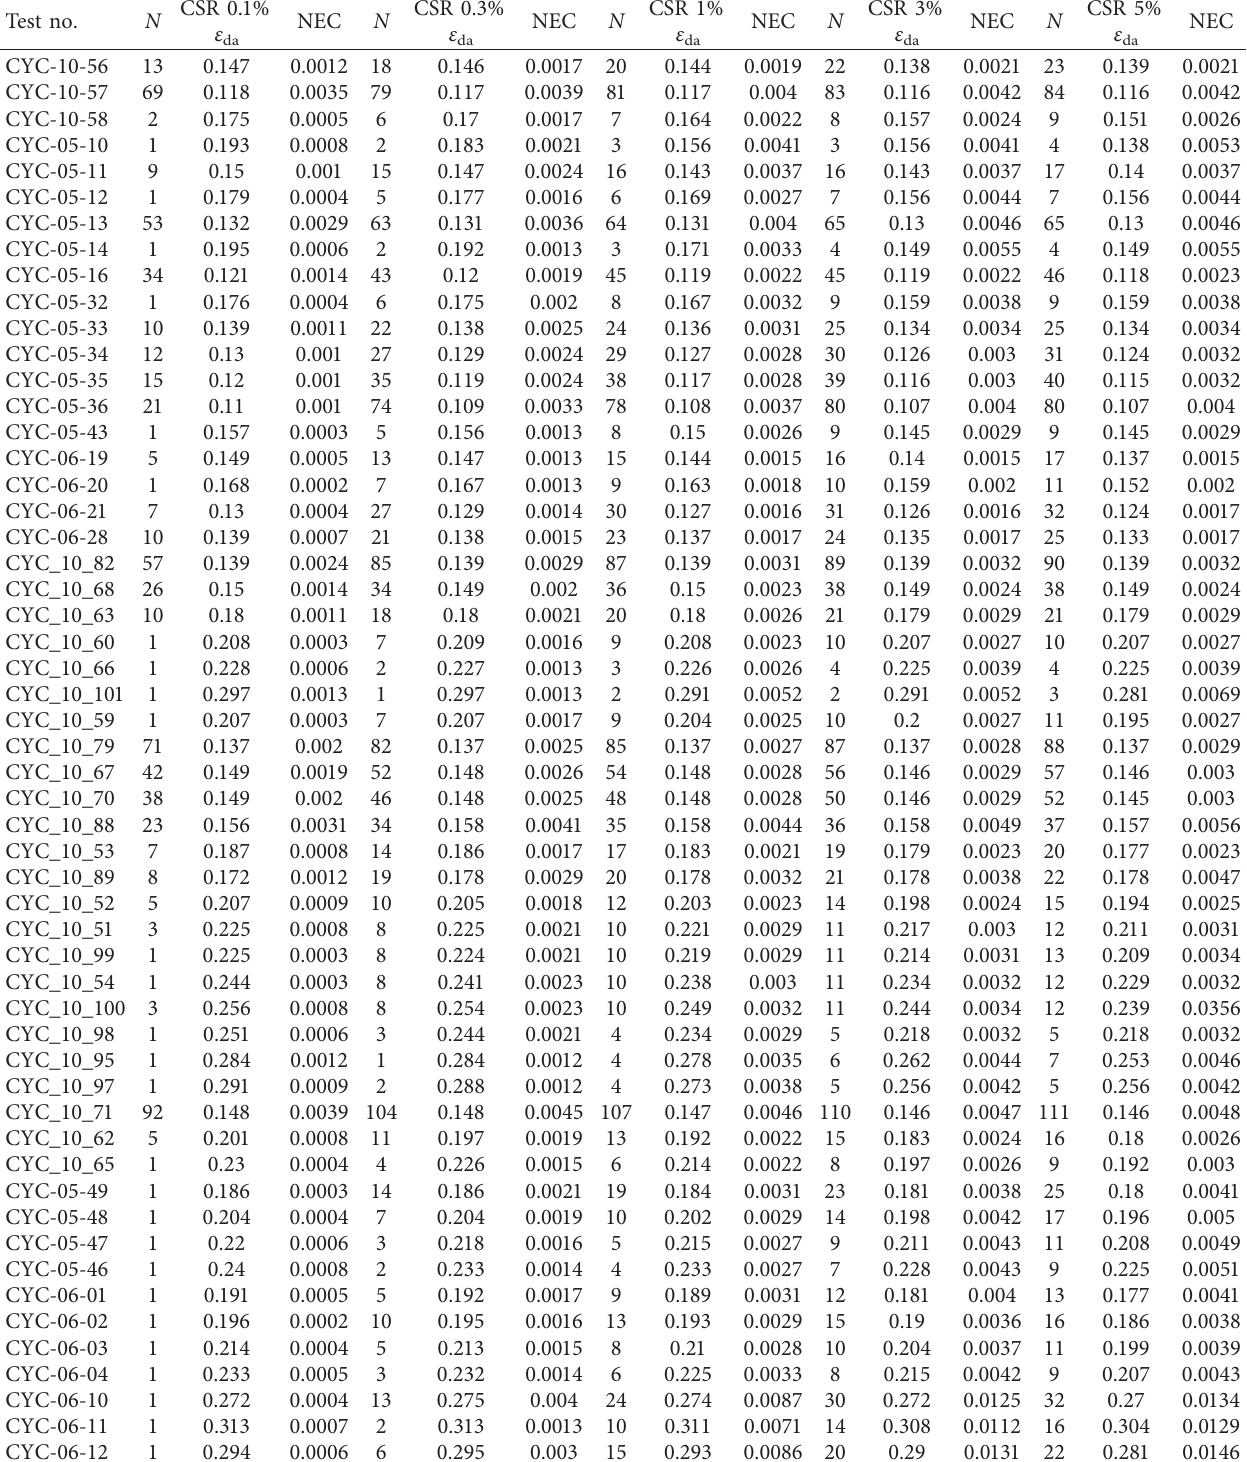
Table 1: Summary of cyclic triaxial tests results from